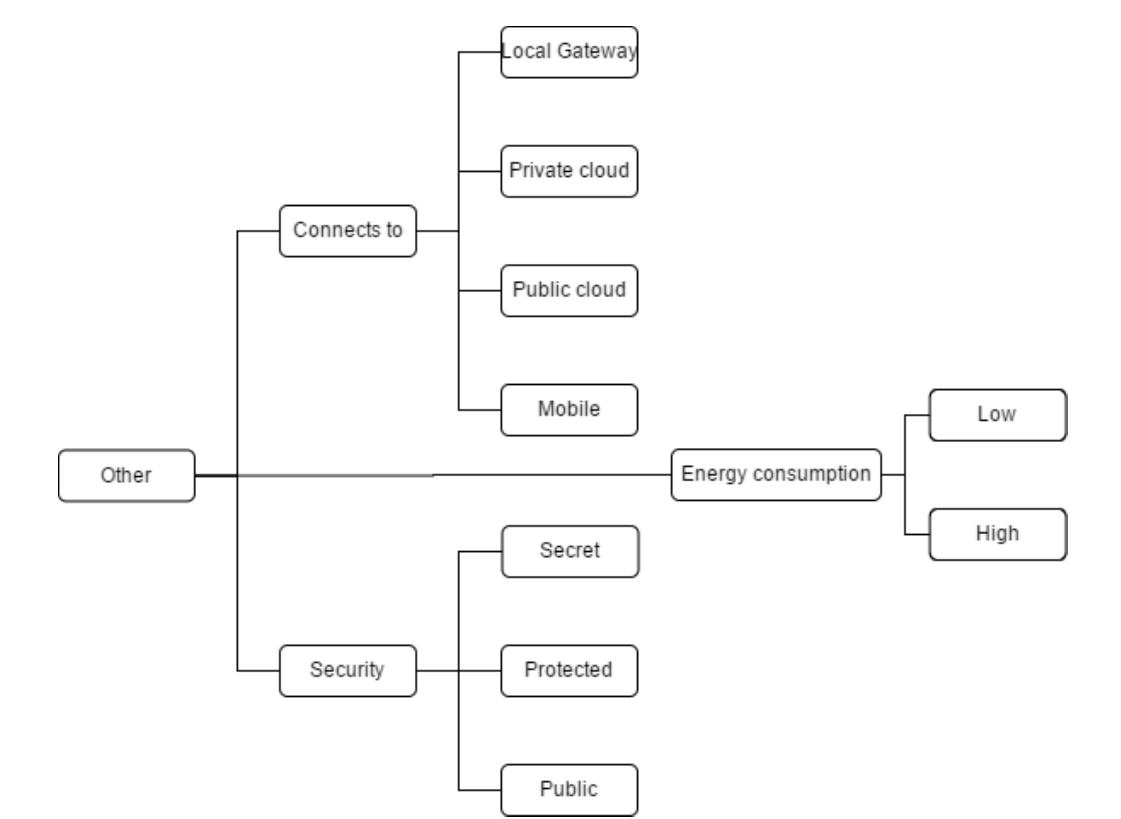
Figure 5. The Other category of the